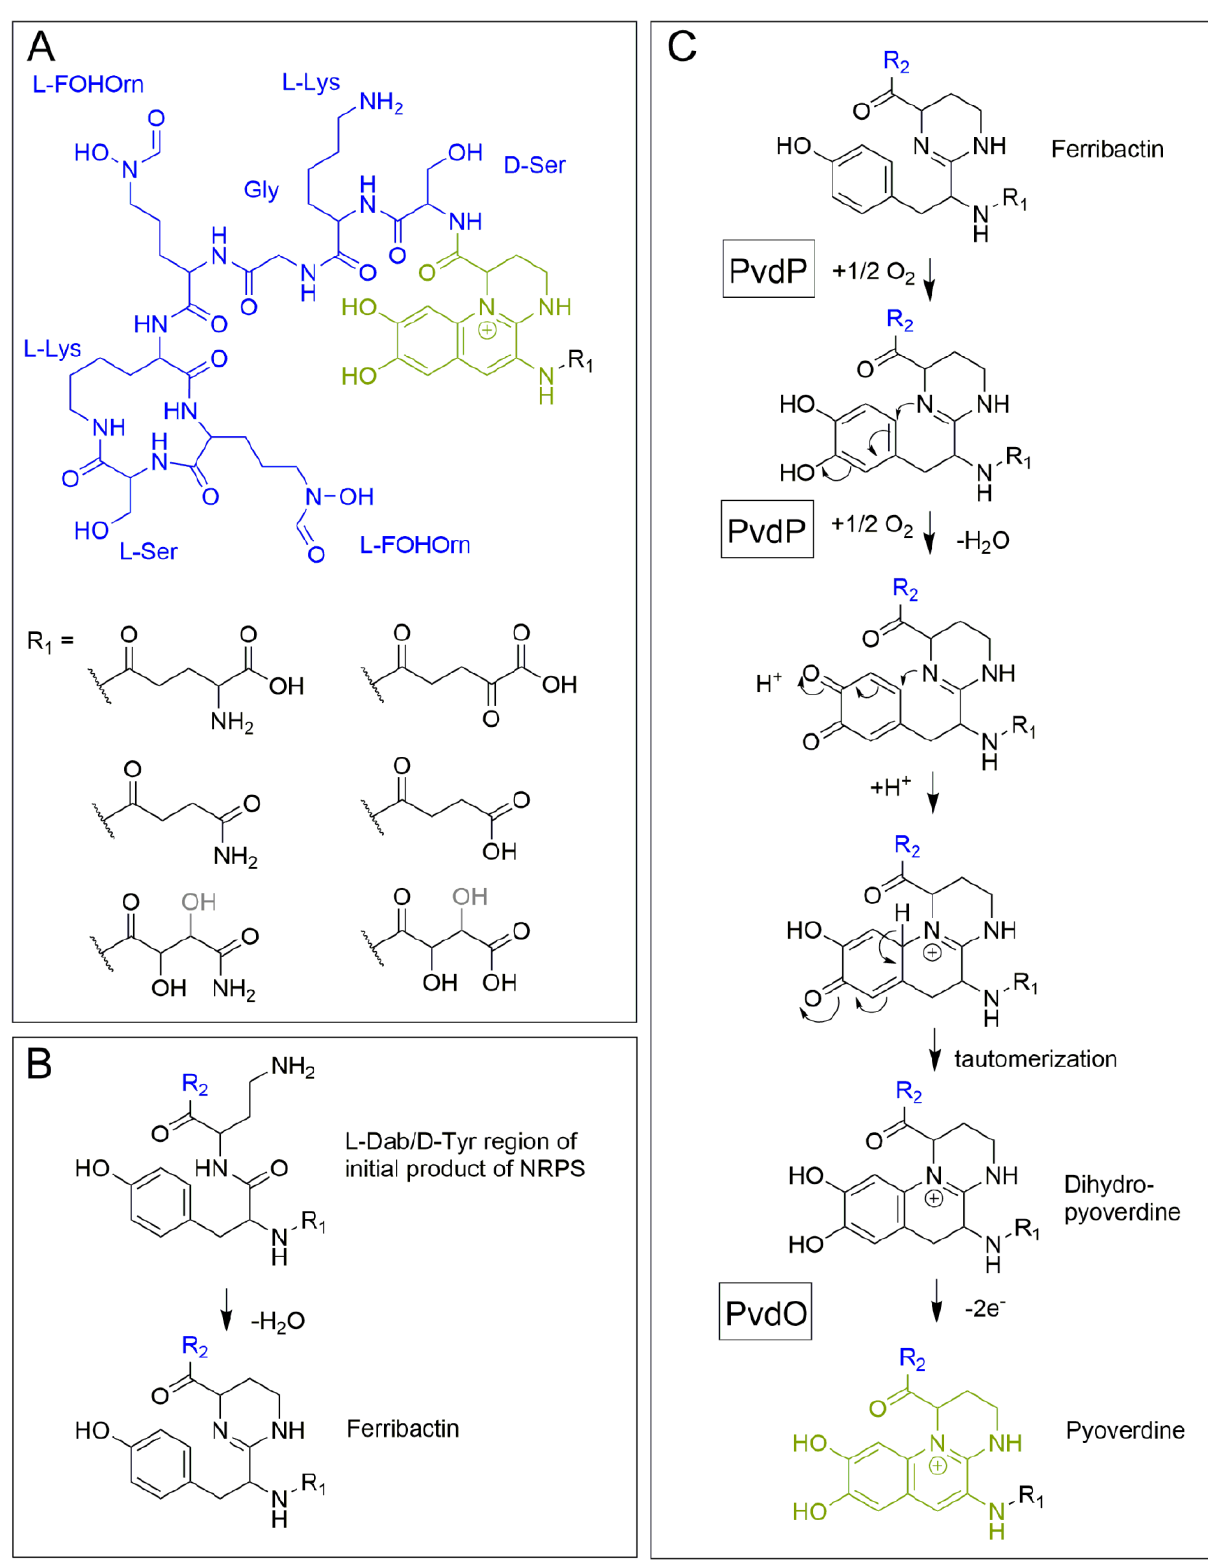
FIGURE 2: Structural aspects of pyoverdines. (A) The structure of pyoverdine from P. fluorescens A506. (B) The condensation occurring in ferribactins. (C) Current model of periplasmic pyoverdine fluorophore biosynthesis. Note that the exact position of the hydroxyl group (black/grey) in malamide or malic acid is not resolved. See text for details. R 2 (blue) designates the peptide